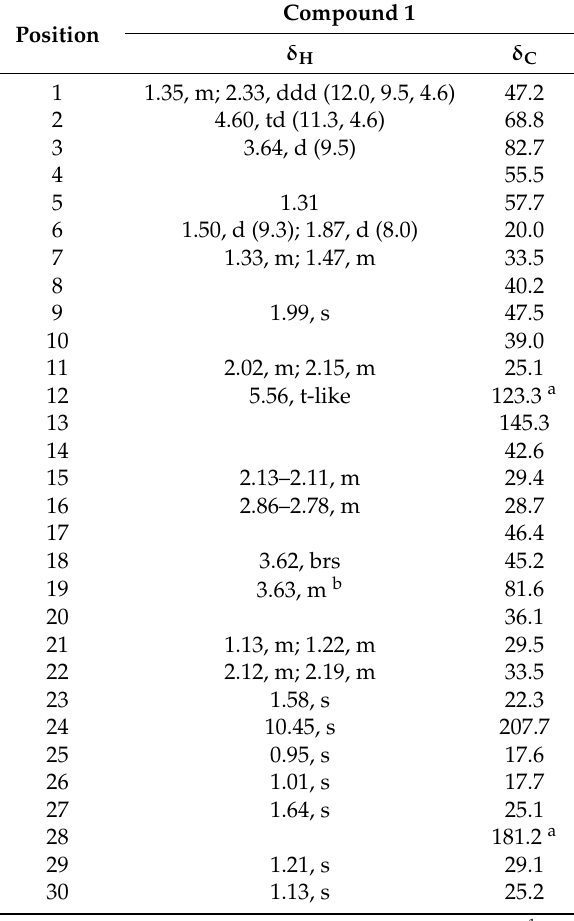
Table 1. 1 H- and 13 C-NMR Spectroscopic Data for Compound 1 a in C 5 D 5 N. Compound Position